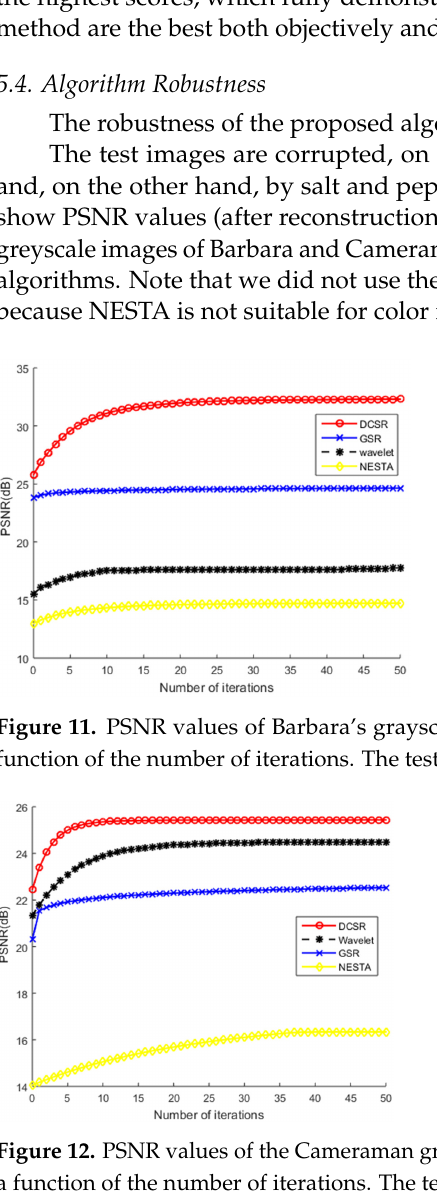
Figure 13. PSNR values of the recovered Lena color image by the competing methods vs. iteration number. The test image is corrupted by AWGN. Figure 14. PSNR values of the recovered Lena color image by the competing methods vs. iteration number. The test image is corrupted by salt and pepper noise.